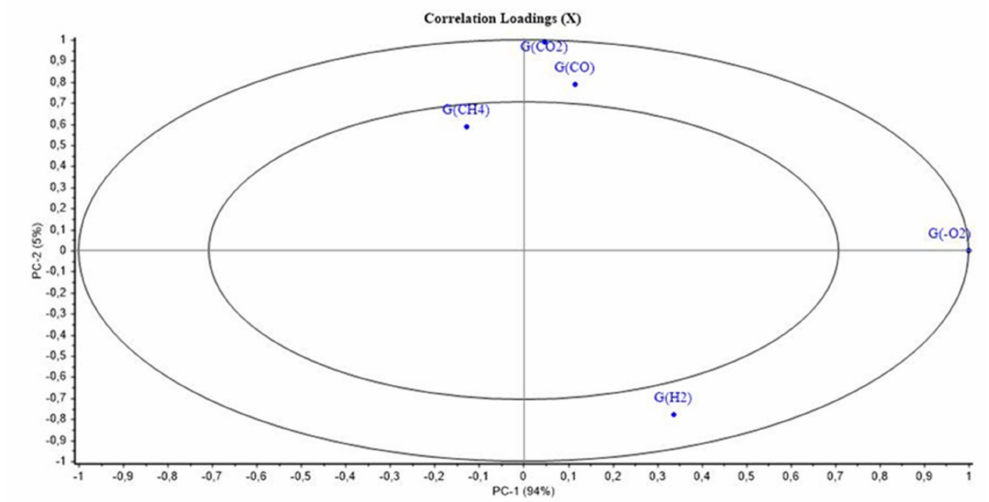
Figure 12. PCA loading for PC1 and PC2 (Mod